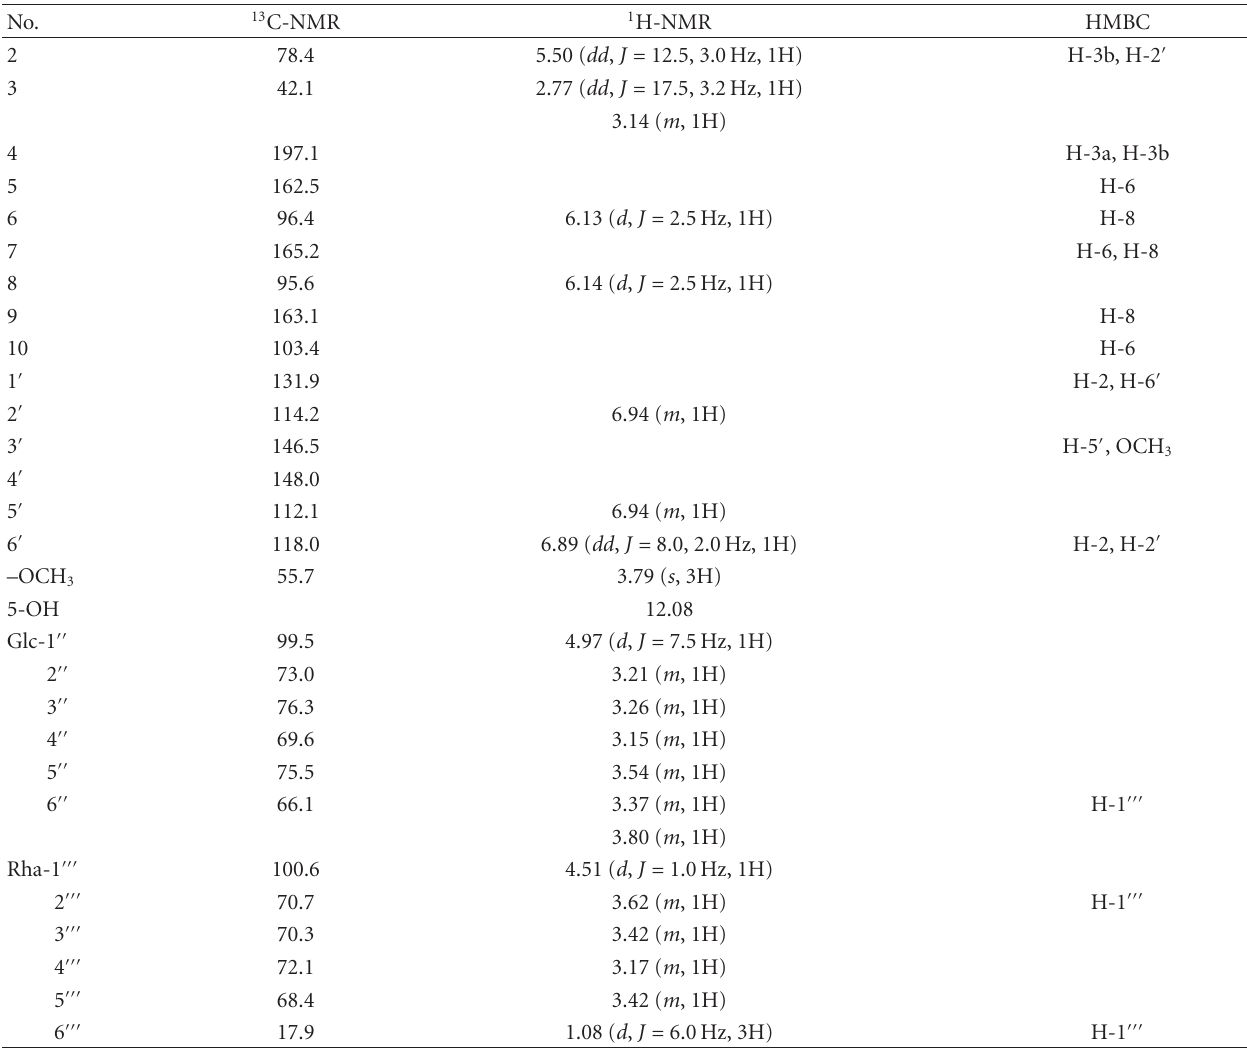
Table 2: NMR spectra of the compound 9 in DMSO- d 6 .